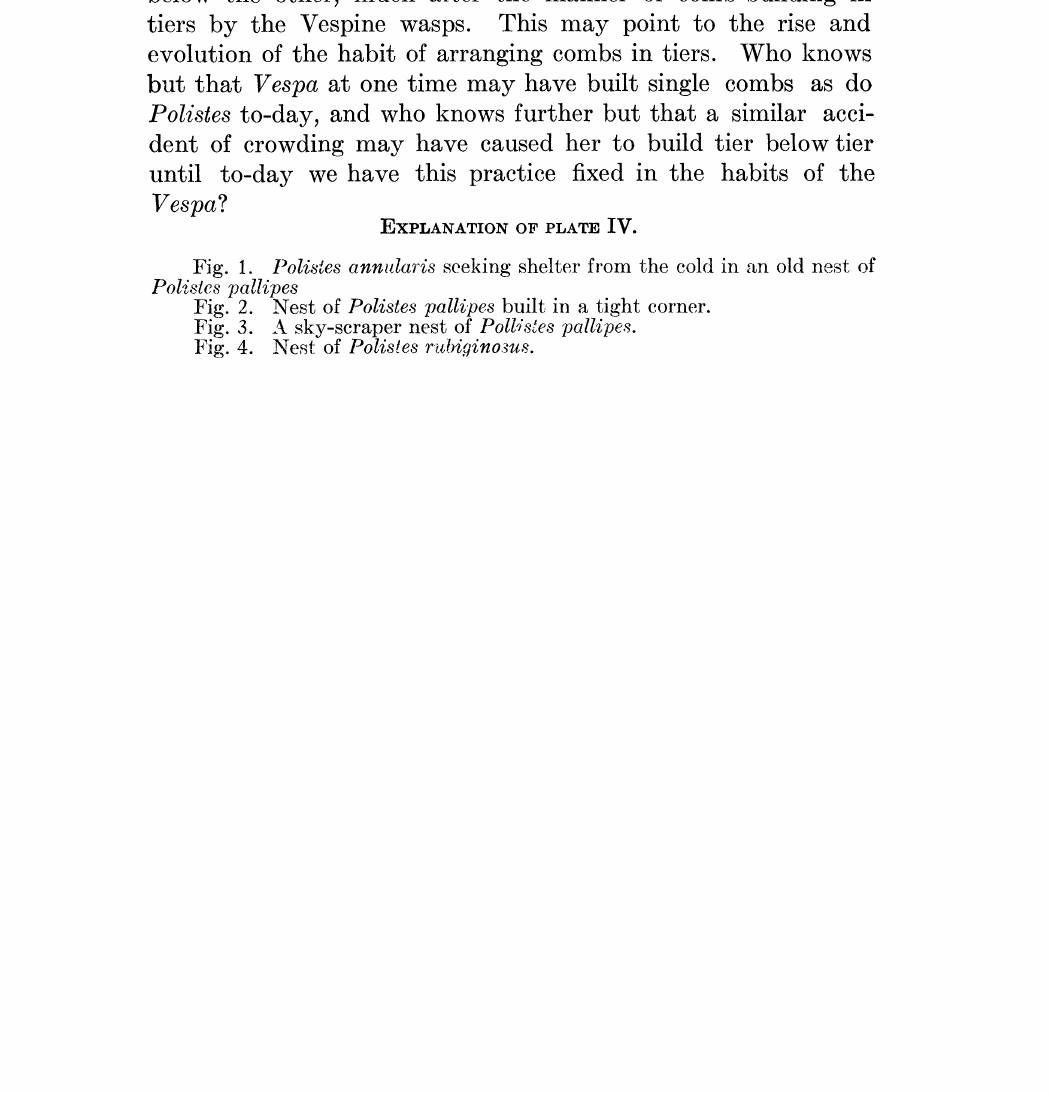
Fig. 1. Polistes annularis seeking shelter from the cold in an old nest of Polislcs pallipes Fig. 2. Nest of Polistes pallipes built in a tight corner. Fig. 3. A sky-scraper nest of Pollistes pallipes. Fig. 4. Net of Polis!es